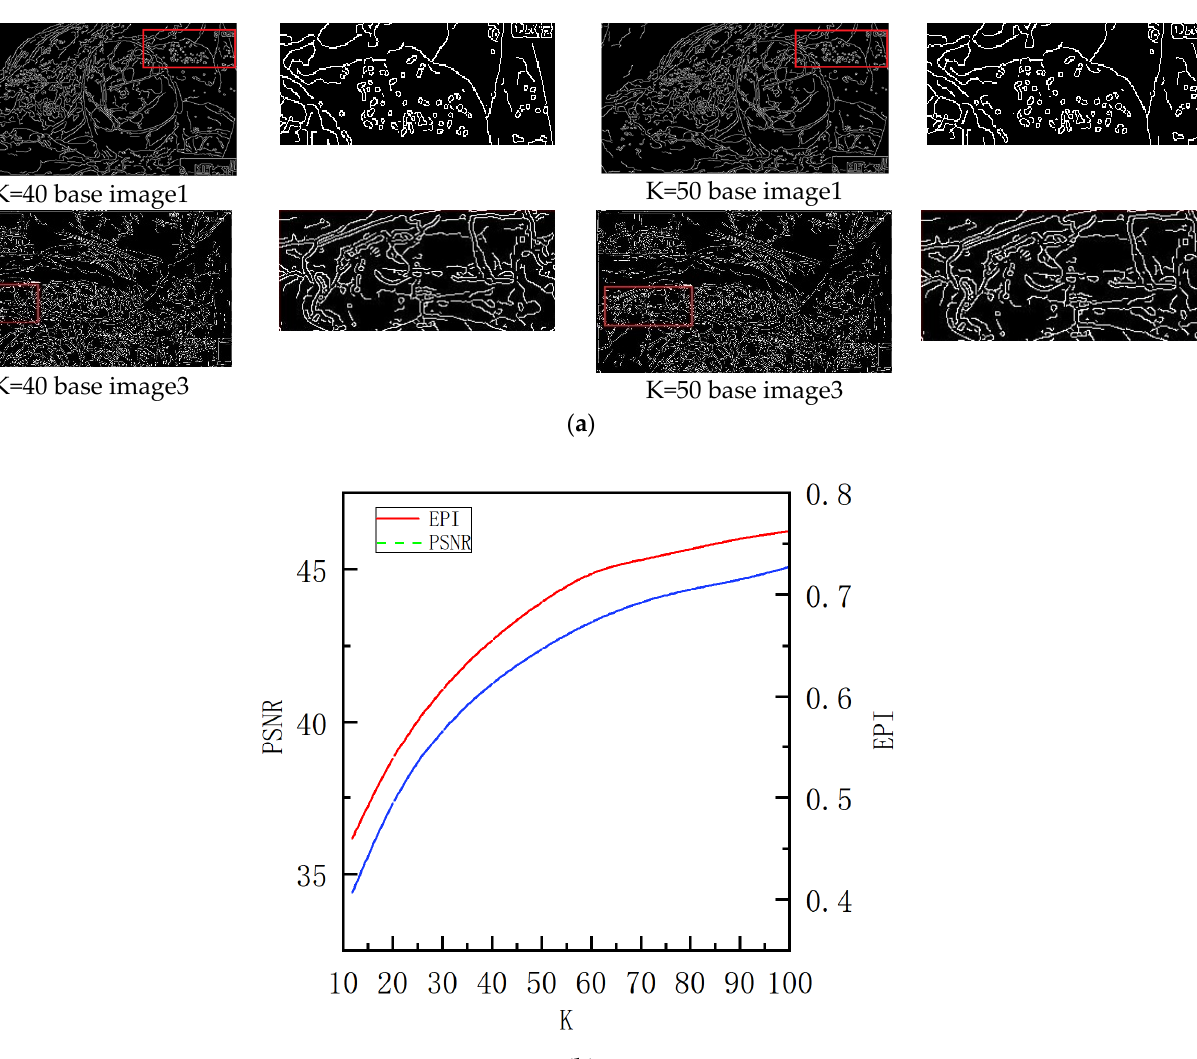
Figure 8. ( a ) The canny operator discovers the structure layer as the value of k changes. ( b ) PSNR of the structure layer and EPI value of the structure layer relative to the original image.